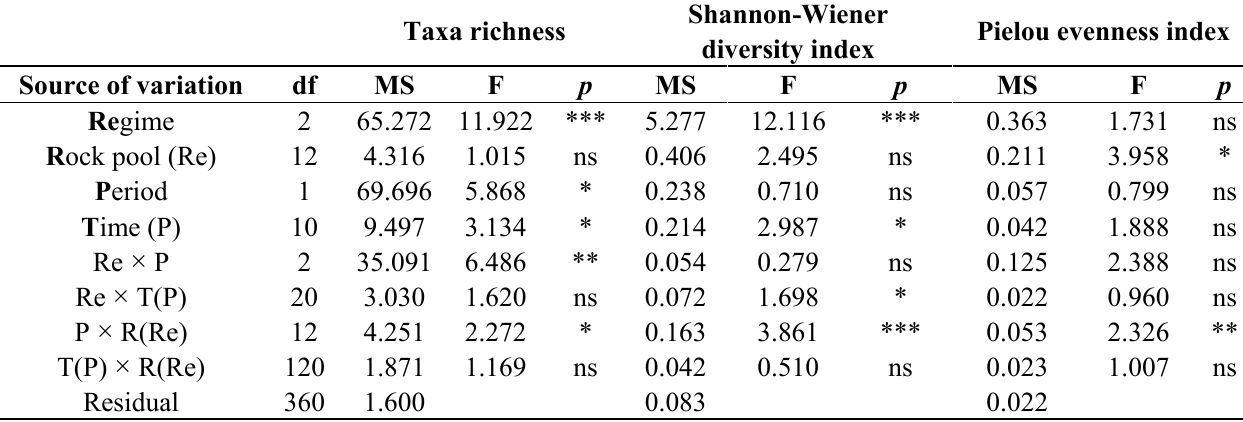
Table 3. Univariate analysis performed with a four-way partially hierarchical ANOVA for differences in taxa richness, Shannon-Wiener diversity index and Pielou